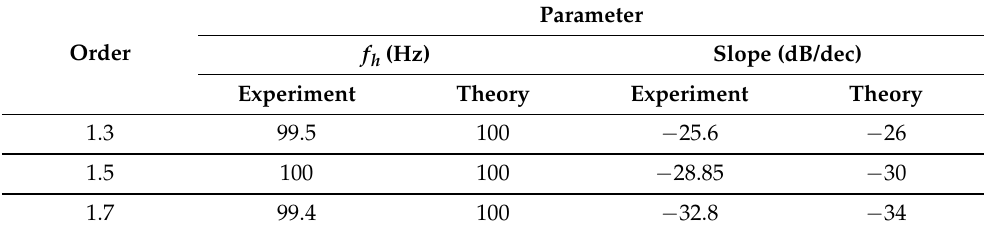
Table 6. Frequency characteristics of LP filter responses in Figure 6.